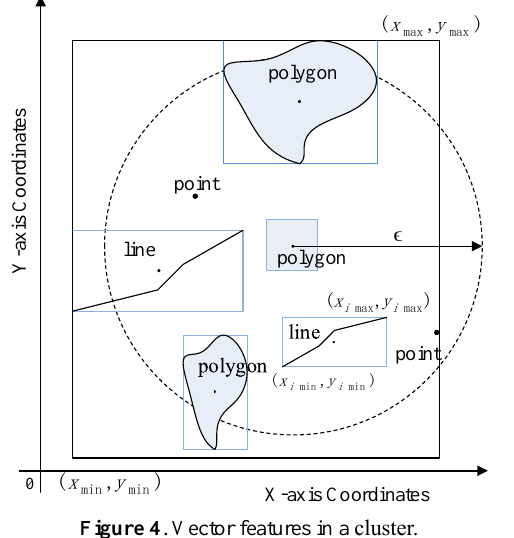
Figure 4 . Vector features in a